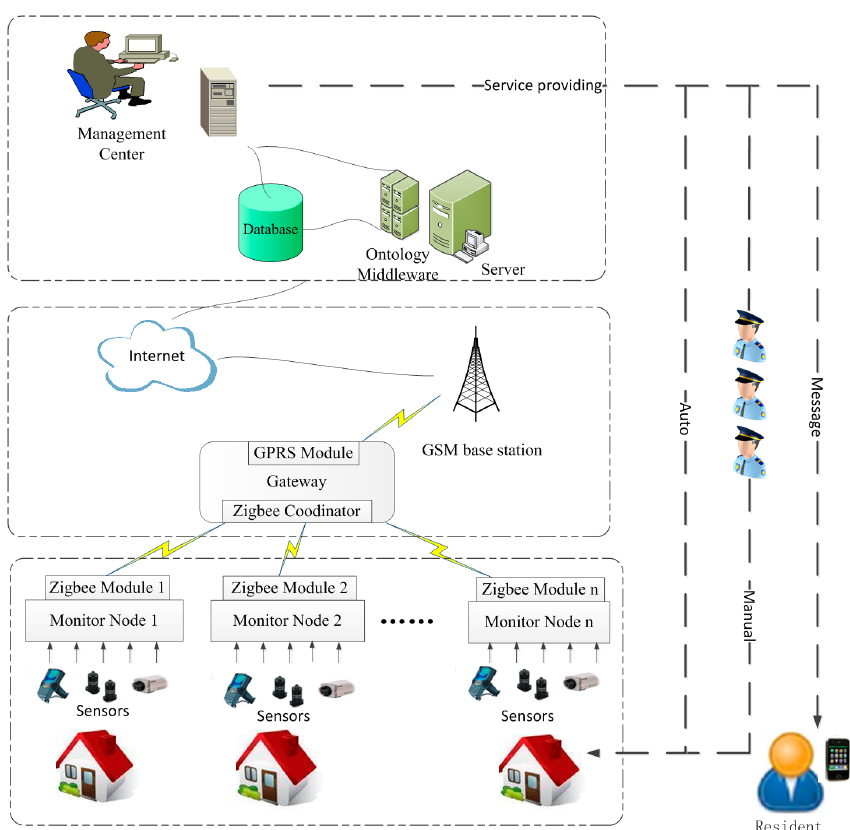
Figure 1. Functional description of the WSN-based SH management system.